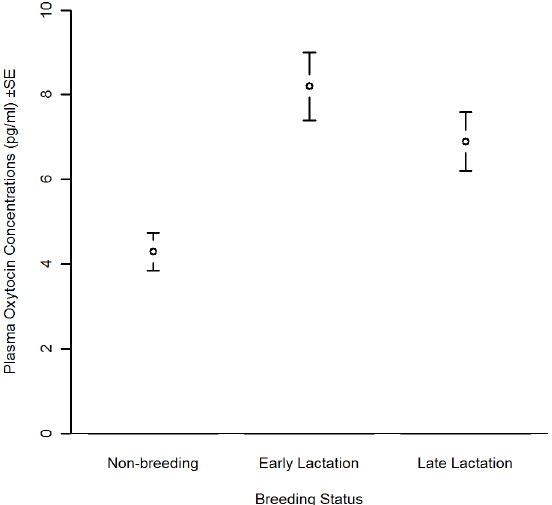
Fig 1. Basal Plasma Oxytocin and Breeding Status. Mean basal plasma oxytocin (pg/ml) across three different breeding statuses, non-breeding females (n = 8), mothers with dependent pups in early lactation (n = 31) and mothers with dependent pups in late lactation (n = 31) with standard error